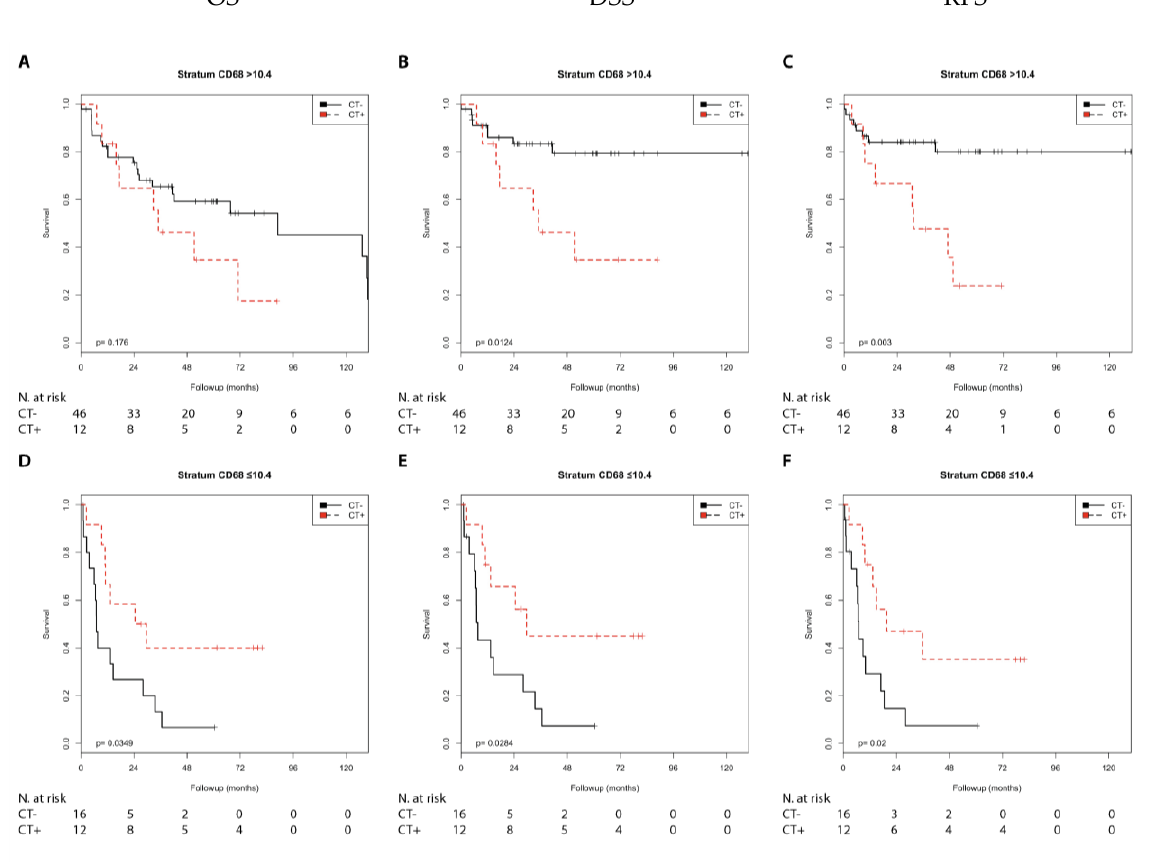
Figure 5. Kaplan–Meier analysis: Association of chemotherapy with prognosis (OS, DSS, and RFS) in the N0/N1 + 2 groups stratified by CD68 expression (>10.4 or ≤ 10.4). In the N0 group ( A – C ) with CD68 (>10.4), chemotherapy was not associated with OS ( A ) but with shorter DSS ( B ; p = 0.012) and shorter RFS ( C ; p = 0.003). In the N1 + 2 group ( D – F ) with CD68 ( ≤ 10.4), chemotherapy was associated with longer OS ( D ; p = 0.035), longer DSS ( E ; p = 0.028), and longer RFS ( F ; p = 0.020).